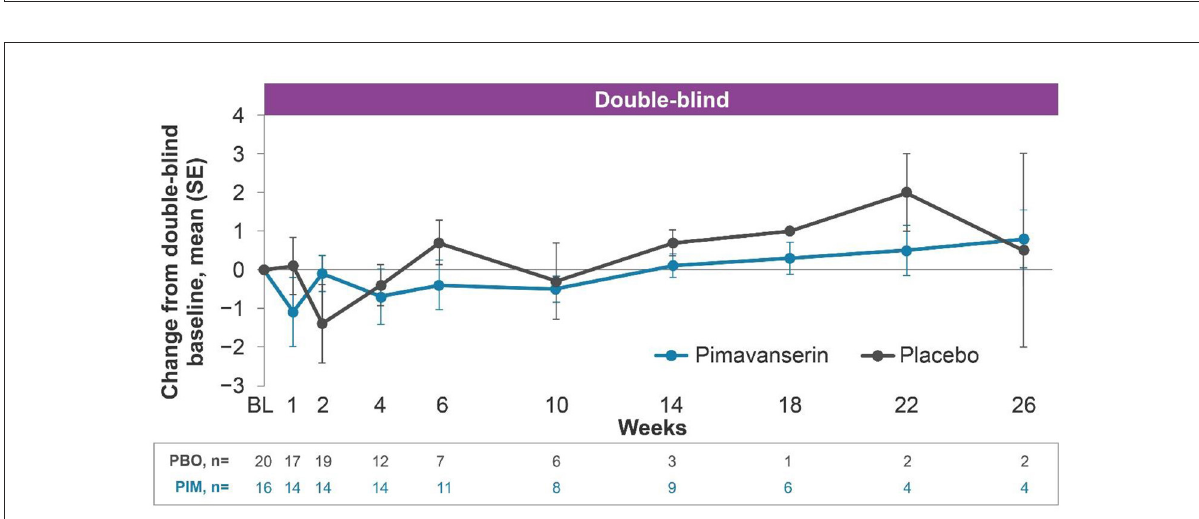
FIGURE3 Change from baseline MMSE score, HARMONY PD dementia with psychosis (pimavanserin 34mg) subgroup. PD dementia with psychosis pimavanserin 34-mg subgroup as of study end date data cutoff of Oct, 30 2019. BL, baseline; MMSE, Mini-Mental State Examination; PBO, placebo; PD, Parkinson’s disease; PIM, pimavanserin; SE, standard